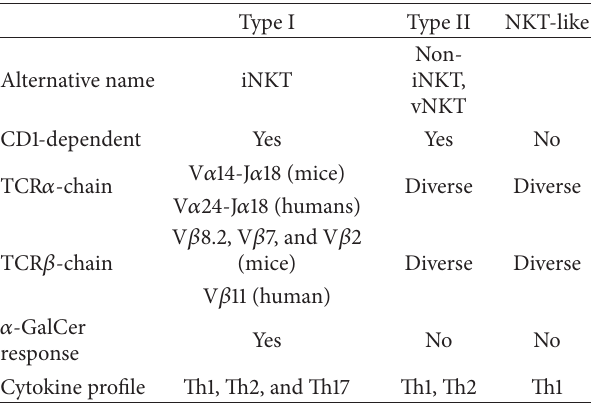
Table 1: Classifications of NKT